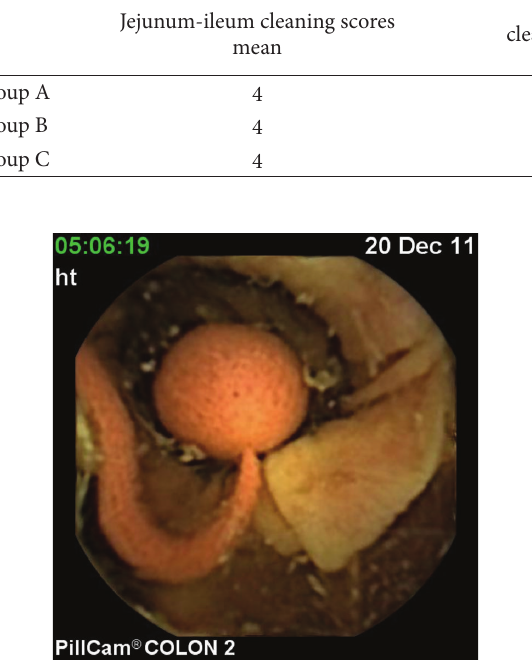
Figure 2: Image of pedunculated polyp in transverse colon in CCE.